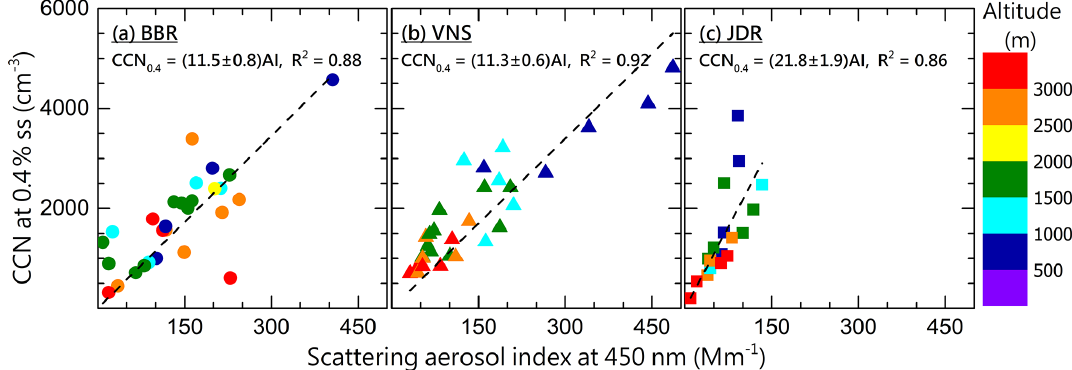
Figure 11. Association between the total scattering AI at 450nm and CCN number concentration at 0.4% supersaturation for the (a) eastern (BBR), (b) central (VNS) and (c) western (JDR) IGP regions. The colour indicates the altitude of measurement. Dashed lines represent the linear least-squares fit to the points for each region. Regression slopes and squared correlation coefficients are written in each panel.